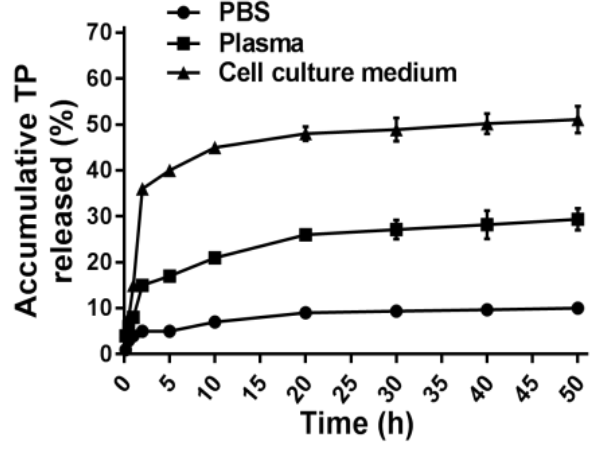
Figure 1. The controlled release manner of TP-CMCS.